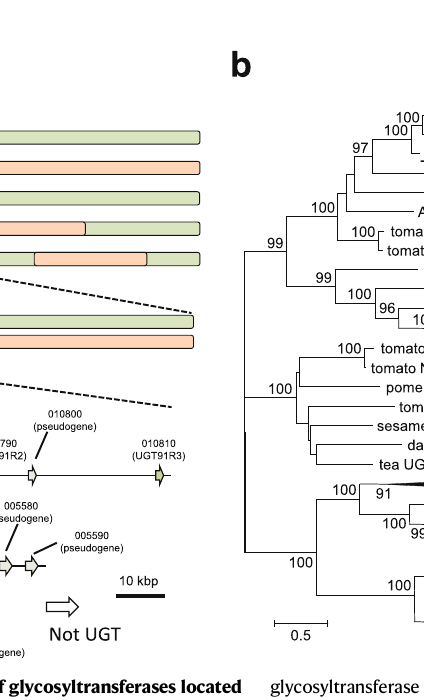
glycosyltransferase genes, and the corresponding gene IDs (https://solgenomics. net/) are shown. b Phylogenetic tree of glycosyltransferases constructed from biochemically identi fi ed glycosyltransferases involved in specialized metabolites, including volatile glycosides. Sequences from various plant species were collected from GenBank protein database. As a reference for UGT families, UGT genes from Arabidopsis were used, except for UGT94, because this gene does not exist in Arabidopsis . A tree was constructed using the maximum-likelihood method with 1000 bootstrap